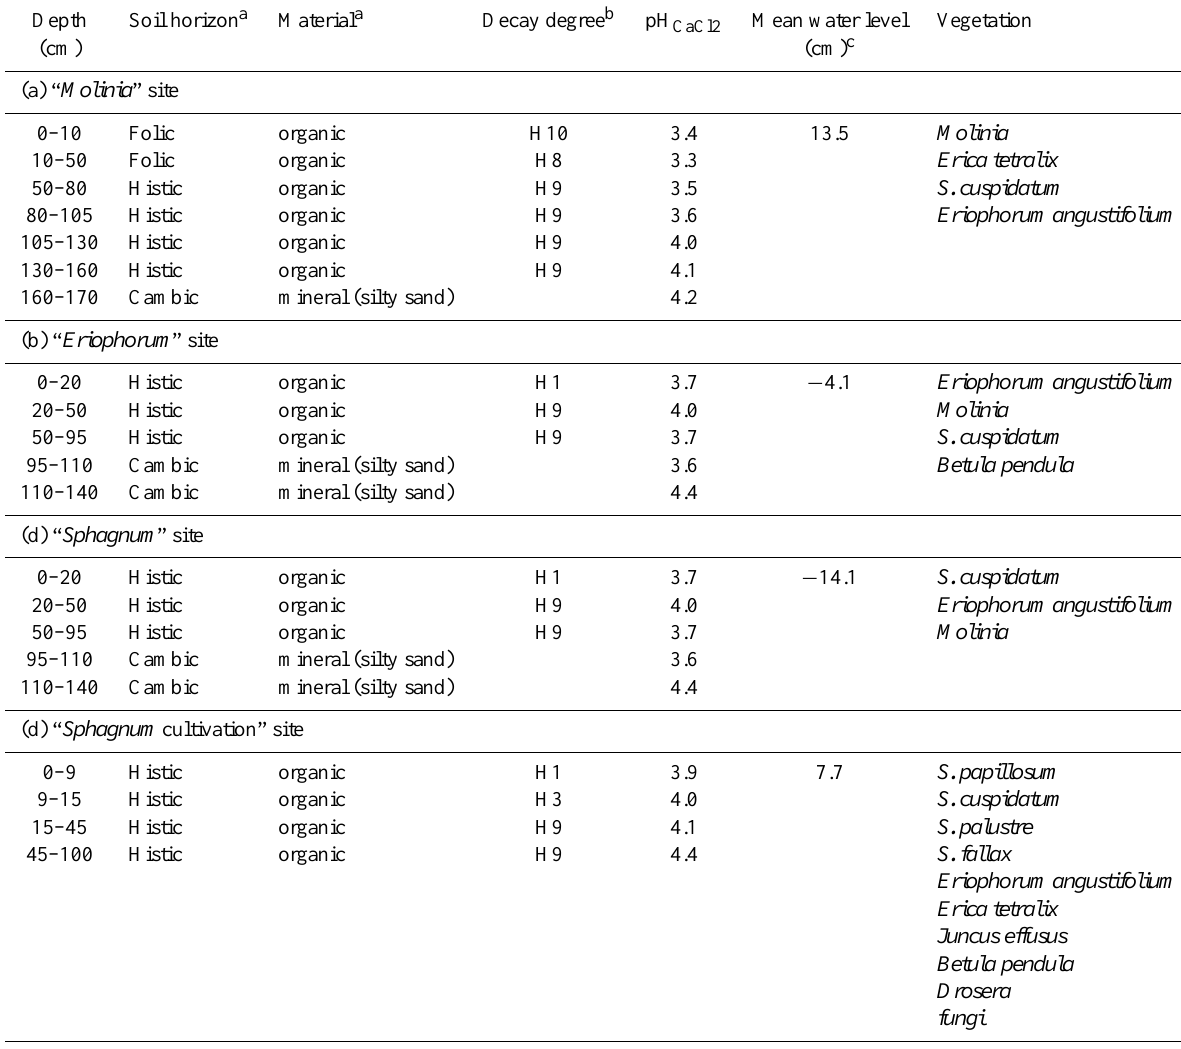
Table 1. Soil properties, mean water level and vegetation at the examination sites.